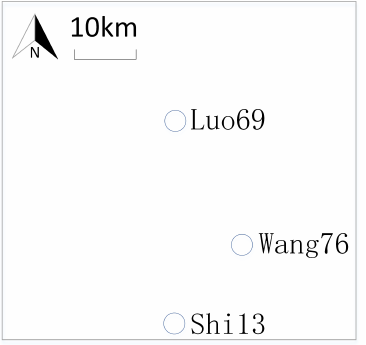
Figure 24. The relative position of the well